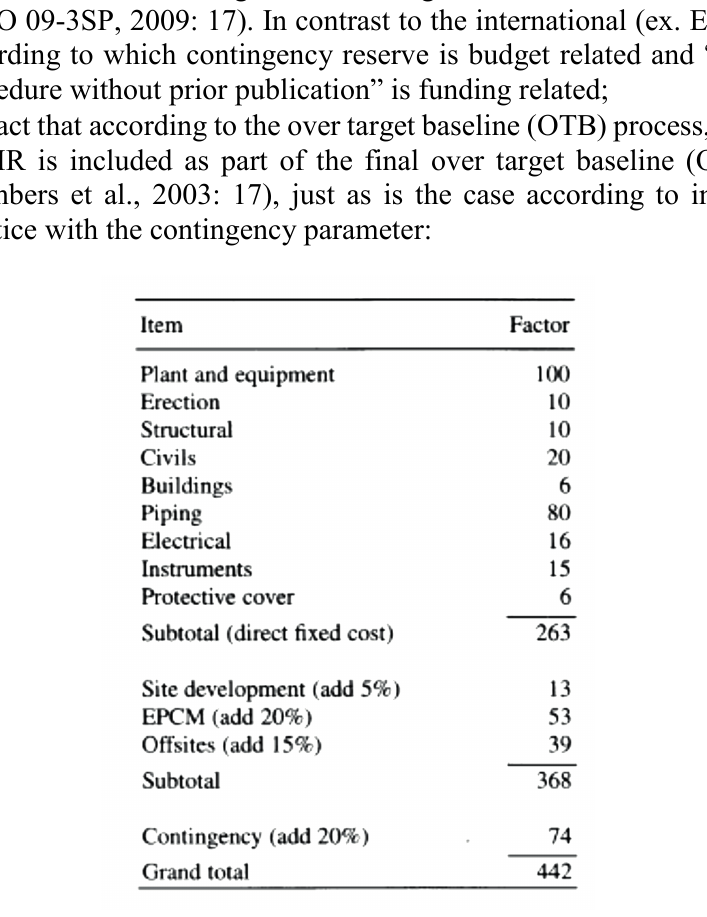
Fig. 9. Final account summary(Crundwell, 2008: